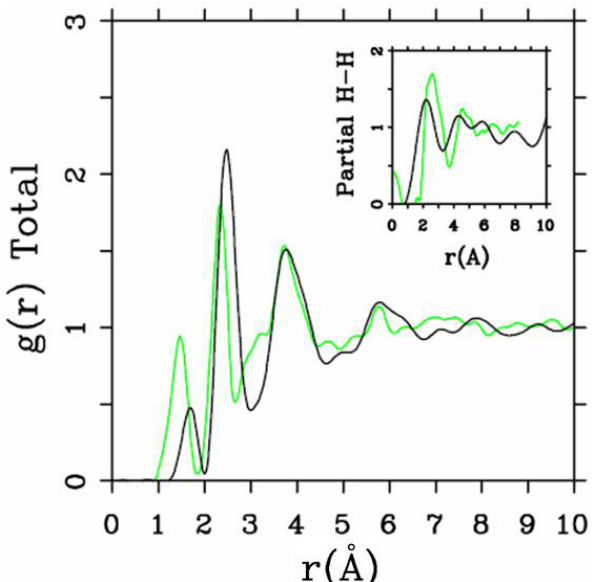
Figure 2. Direct comparison of the simulated total radial distribution function (RDF) and H-H pRDF (Inset) for a-SiH (black lines) to the experimental results (green lines) for the 2.44/0.46 fs cell. These simulations give a better overall description of the observed H–H